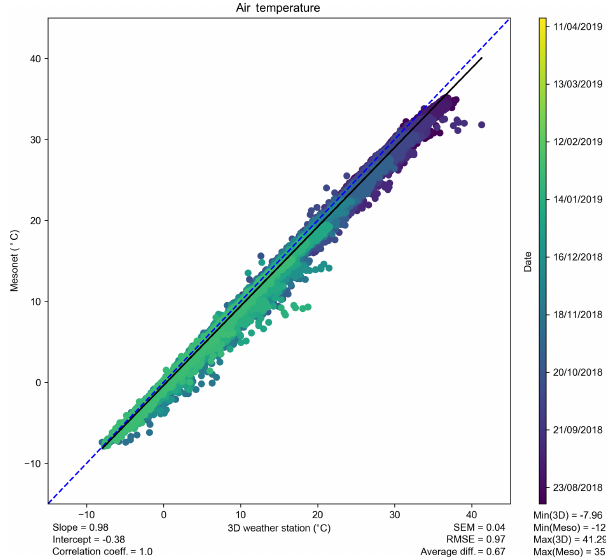
Figure 8. Comparison of the low-cost BMP280 pressure sensor ( x ) and the Oklahoma Mesonet ( y ) for 7 months of the deployment, color-coded by time. The one-to-one reference line (blue dashed) and linear regression line (black solid) are